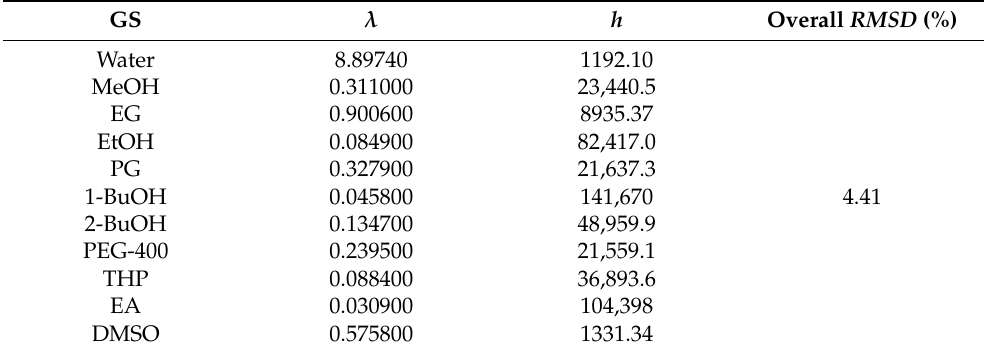
Table 6. ITN “Buchowski-Ksiazaczak λ h model” data for eleven distinct green